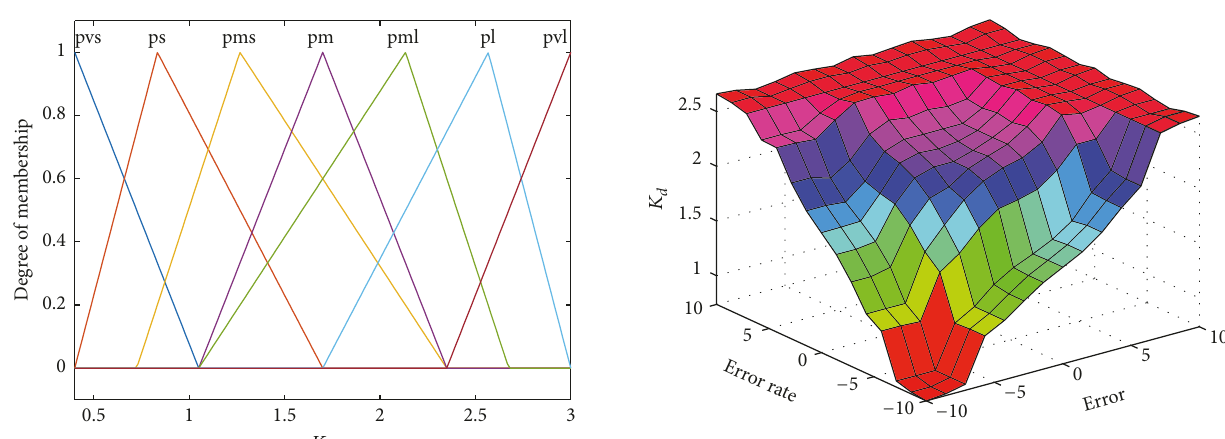
Figure 9: Error and derivative error for the output 𝑘 𝑑 .